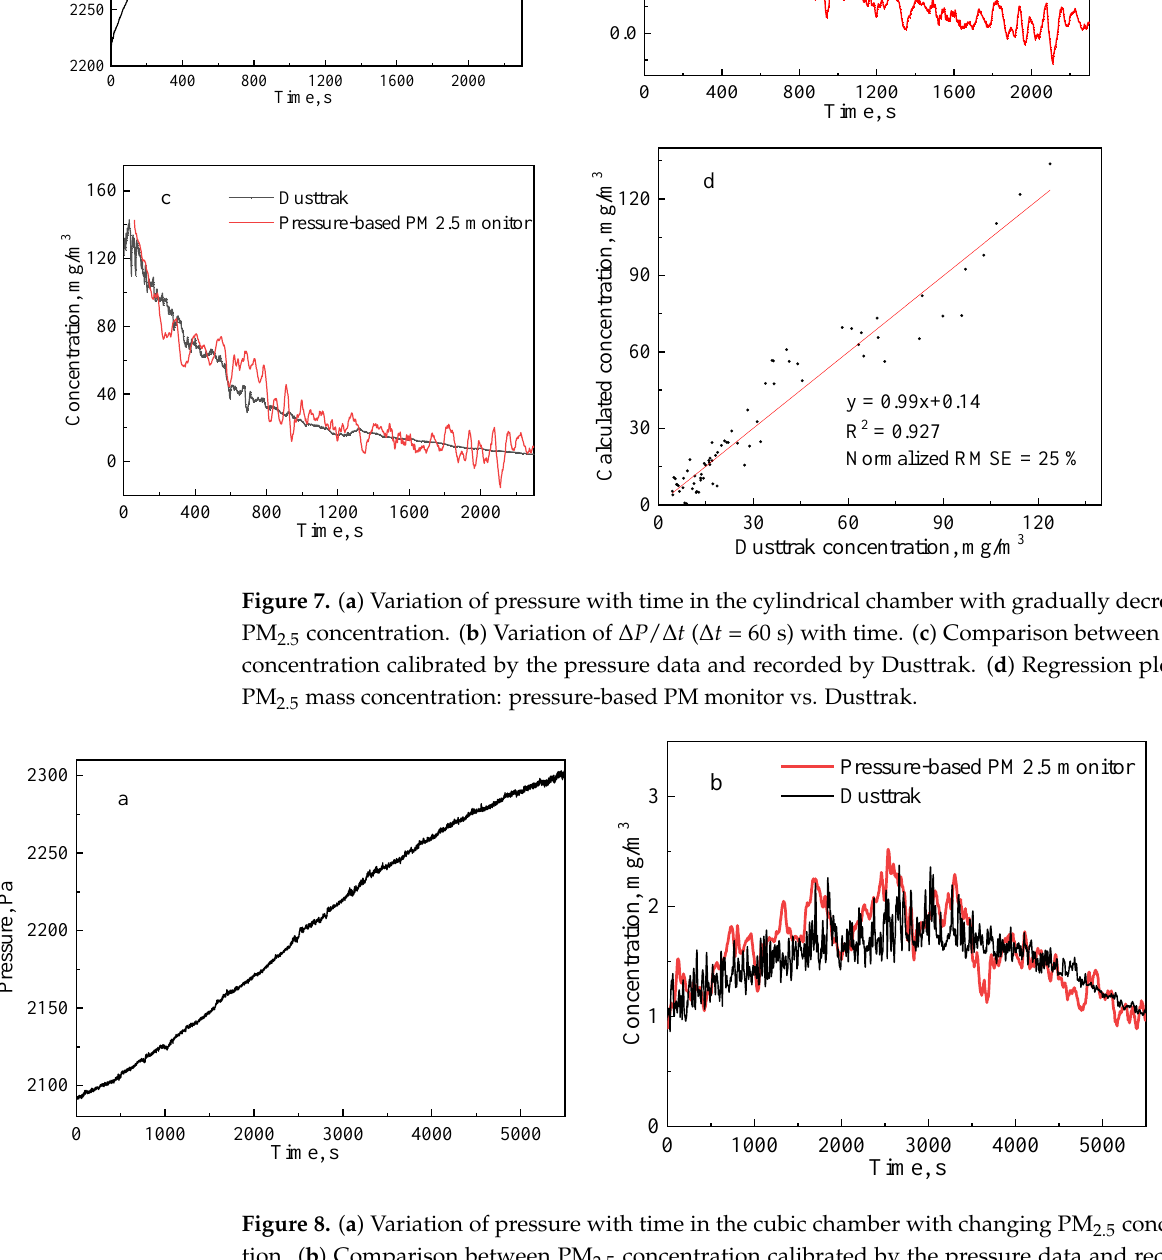
Figure 8. ( a ) Variation of pressure with time in the cubic chamber with changing PM 2.5 concentra- tion. ( b ) Comparison between PM 2.5 concentration calibrated by the pressure data and recorded by Dusttrak.